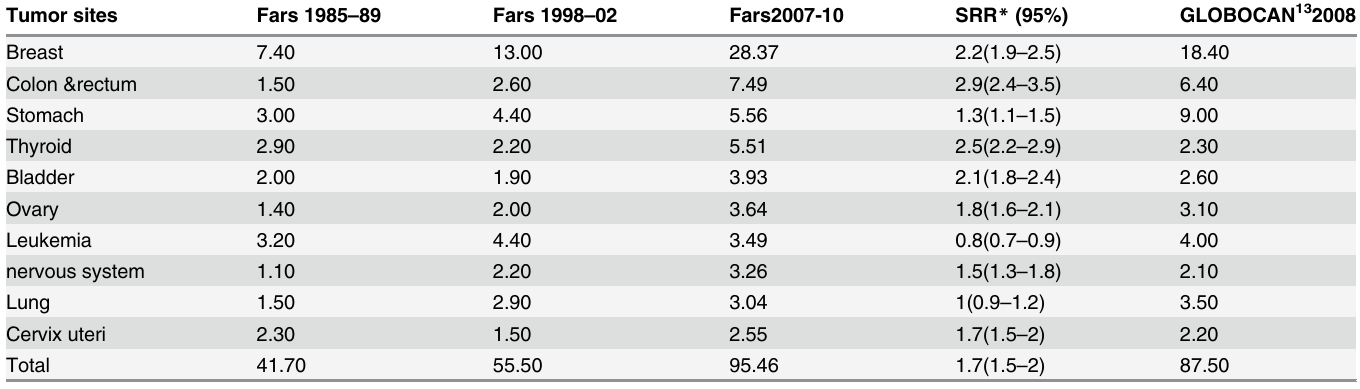
Table 2. Top ten cancers in women based on age-standardized rates per 100,000 person-years (ASR) and standardized rate ratio (SRR) in Fars province comparing to previous studies in Fars, GLOBOCAN 2008. Tumor